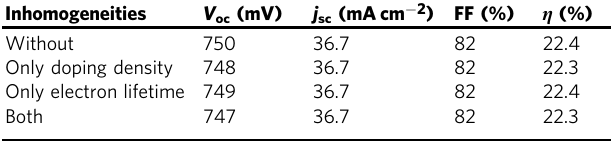
Solar cell parameters extracted from simulated, illuminated j – V curves with respect to the approximated grain structure. Simulation results are divided into different aspects of lateral